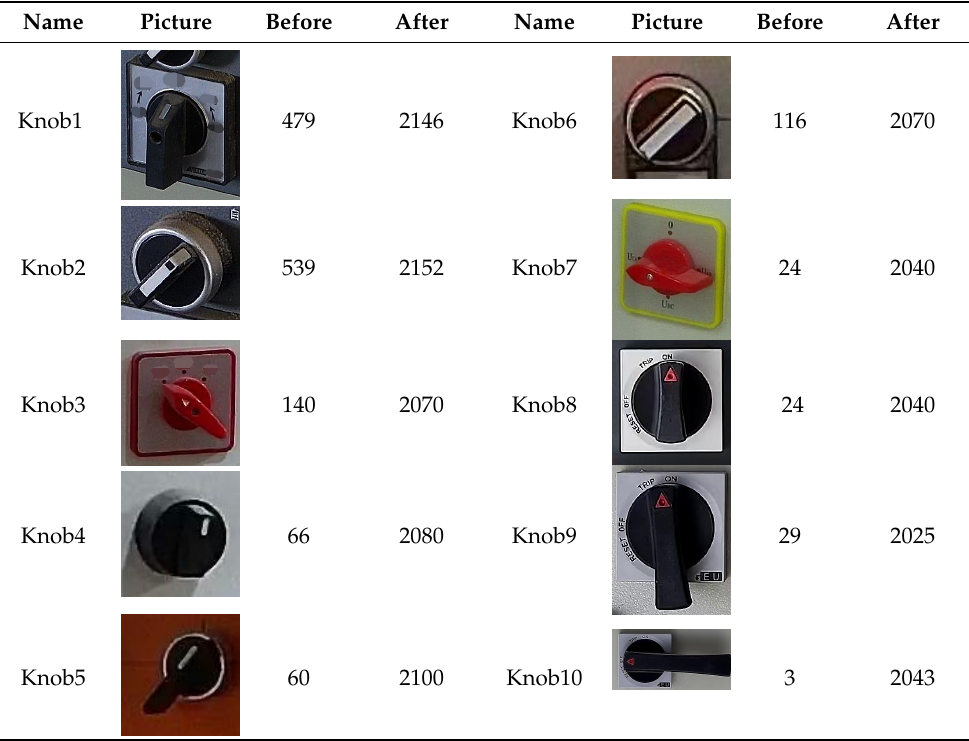
Table 3. Dataset distribution before and after knob